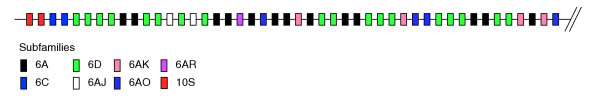
Gene order of families 6 and 10 in cluster Rno7@3-9. This diagram shows the alignment of the first 46 genes of this rat cluster. As shown by the different colors, genes of different subfamilies are intermingled.